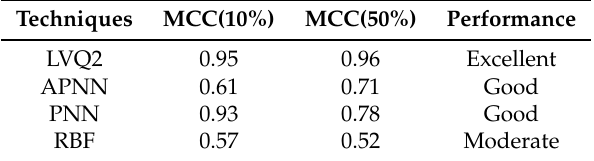
Figure 12. F1-Score and MCC value of various NNs for all faults at 50 % fault rate. Table 2. MCC of various classification techniques at 10 % and 50% fault